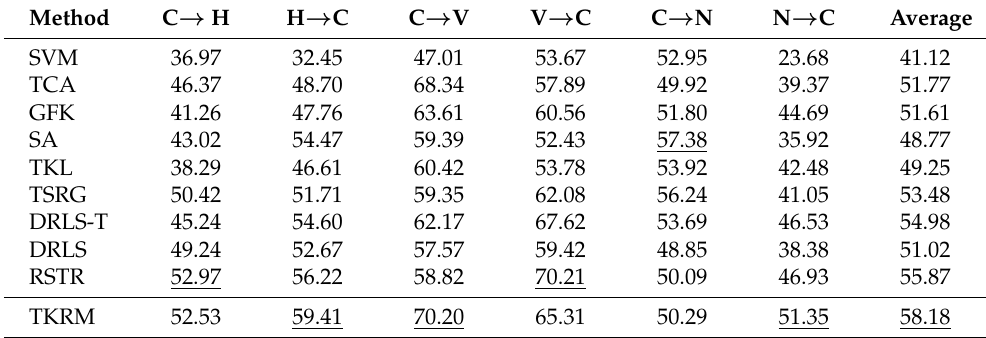
Table 2. The results of cross-database MER experiments in terms of the mean F1-score (%) among CASME II, HS, VIS, and NIR, respectively. The best result in each experiment is underlined.